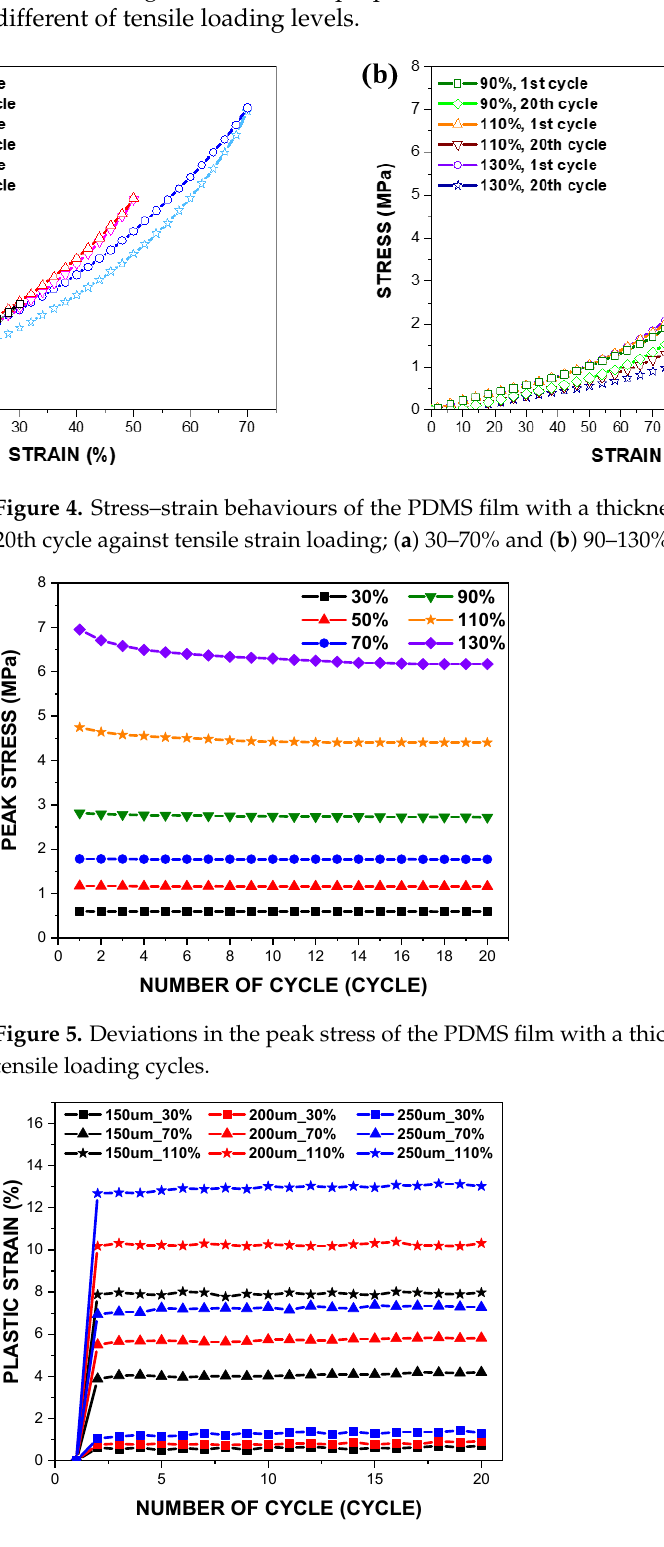
Figure 6. Deviations in plastic strains of all PDMS films subjected to the tensile loading in the ele- vations.